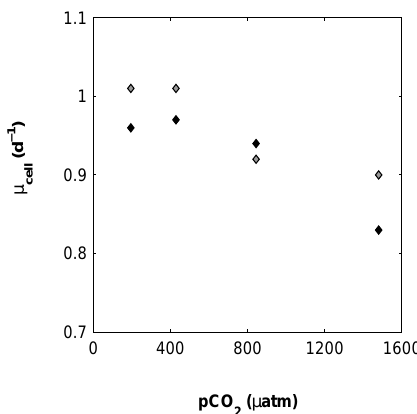
Fig. 4. Cell division rate (µ) based on cell counts of Emiliania hux- leyi in relation to CO 2 levels ( p CO 2 ) . Black diamonds correspond to calculations based on cell counts conducted at the beginning of the light phase (0h) and after 24h and grey diamonds to those done 2h after the start of the light phase and after